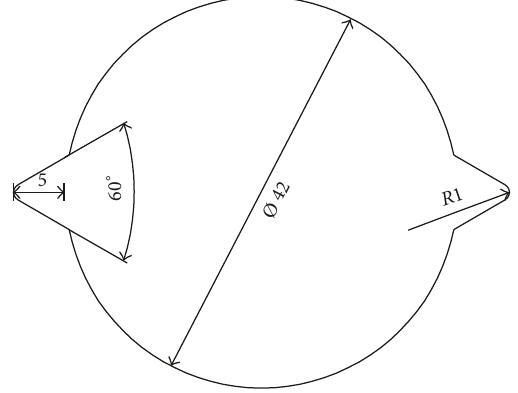
Figure 4: Grooved blast holes